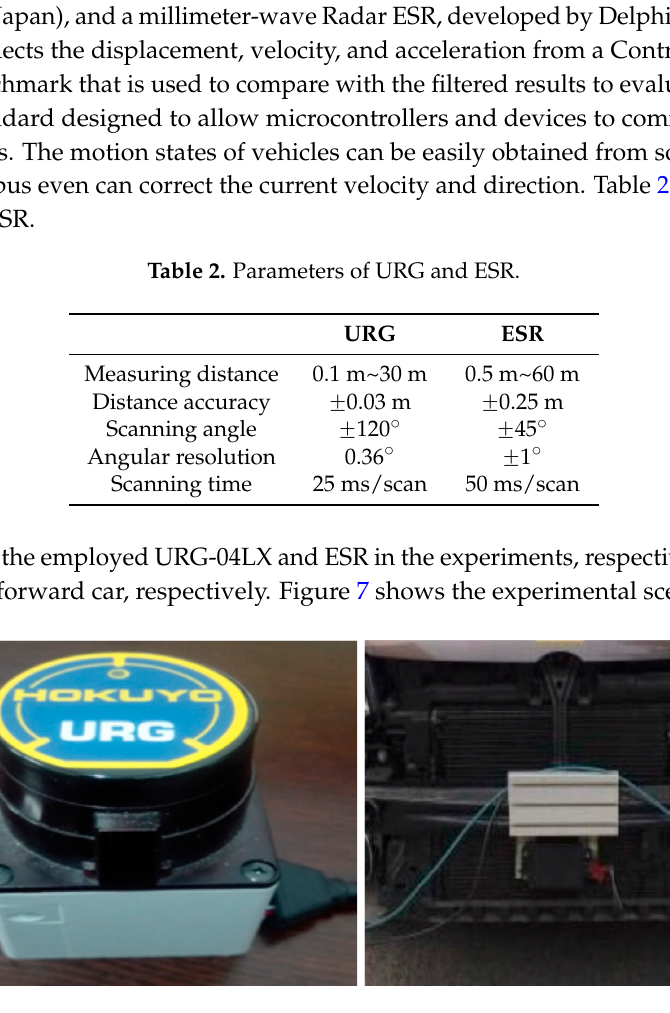
Figure 5. The URG-04LX Lidar ( Left ) and the ESR Radar ( Right ).